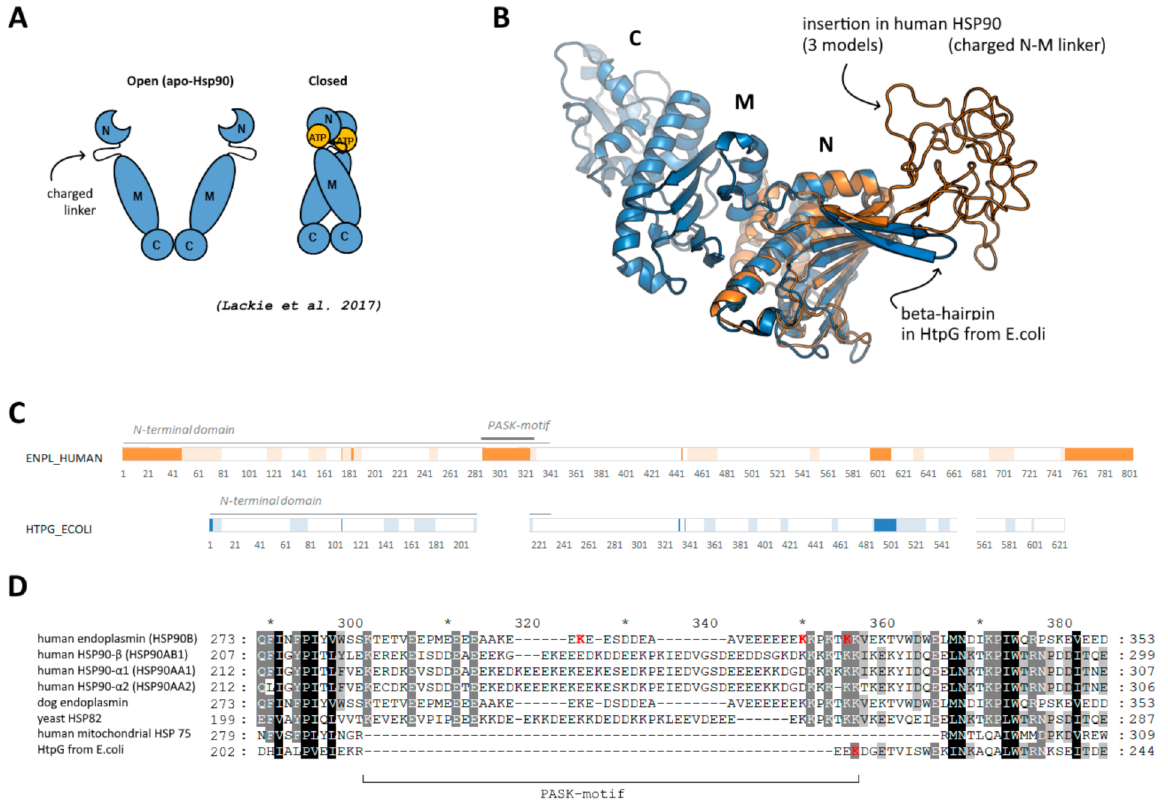
Figure 1. ( A ) Schematic representation of open and closed forms of HSP90, adopted from [18]. ( B ) Location of disordered insertion of PASK-motif in beta-hairpin in N-terminal domain of human endoplasmin (orange) compared to “short” beta- hairpin of bacterial HSP90 (blue); three different initial models are superimposed; middle and C-terminal domains of human endoplasmin are not shown. ( C ) Disordered regions predicted using DISOPRED3 [19] (bright orange/blue) and PONDR [20] (light orange/blue). ( D ) Alignment of the region of the beta-hairpin with the insertion and PASK-motif; reconstructed using Clustal